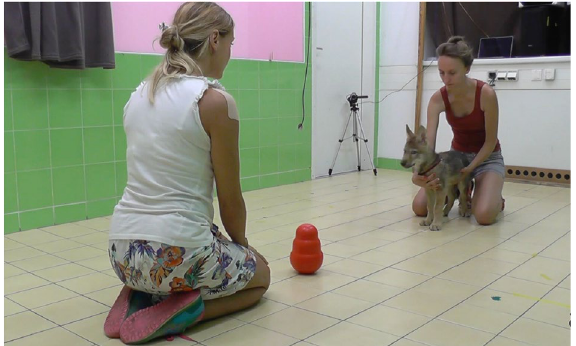
Figure 2. Experimental setup. In the free exploration trial and in the experimental trials, the demonstrator is within reaching distance from the object. The owner gently holds the subject at its chest, in front of him/her. In the trials with demonstration, the demonstrator makes eye contact and uses ostensive communication before and during the